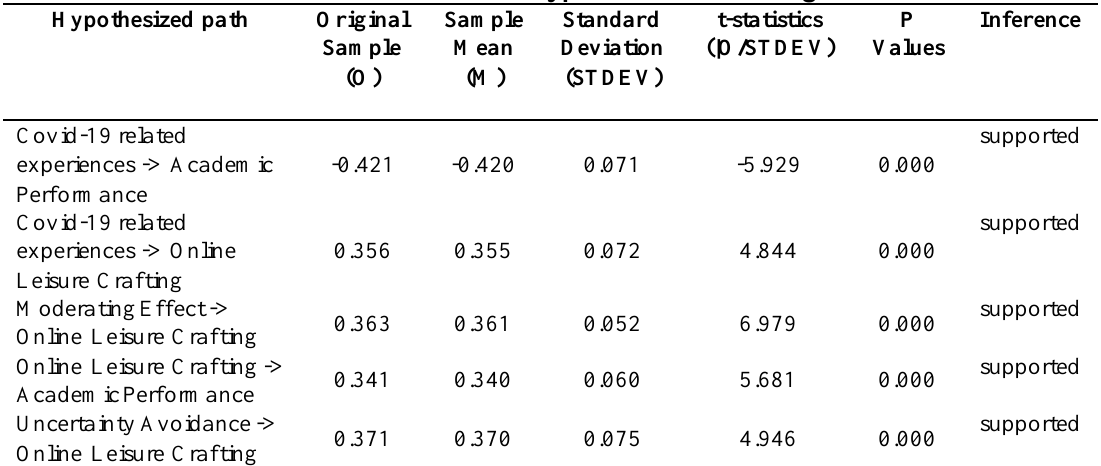
Table.5. Research hypotheses and